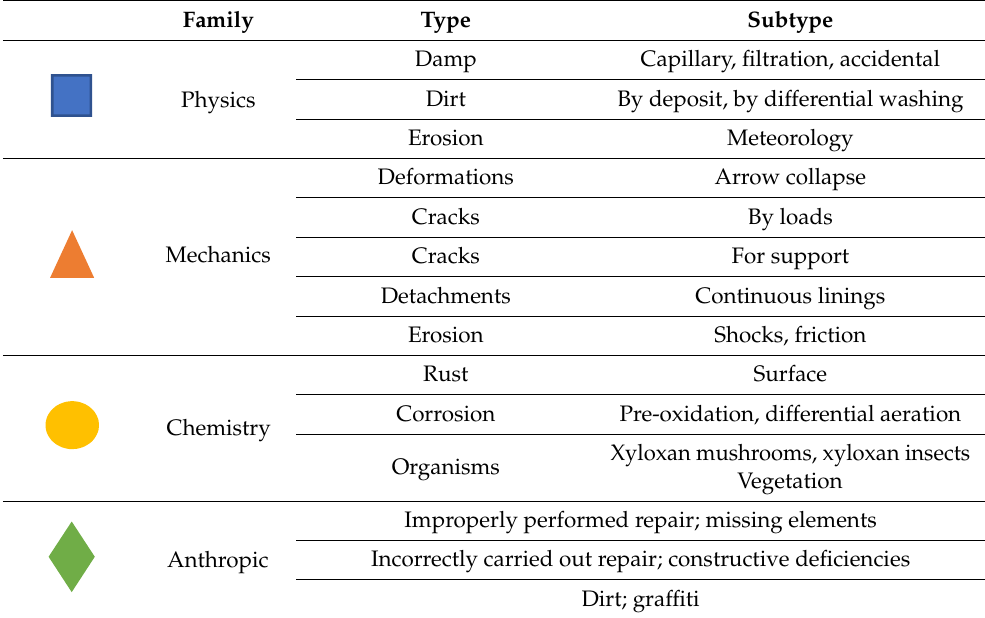
Table 9. Classification scheme for lesions that cause pathological processes. Family Type